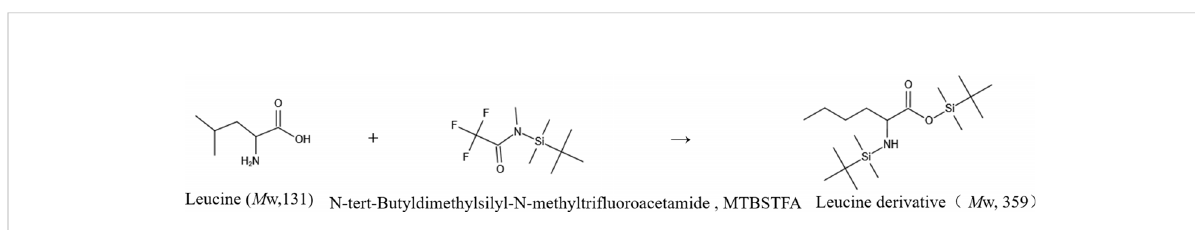
FIGURE 5 Leucine derivatization reaction.